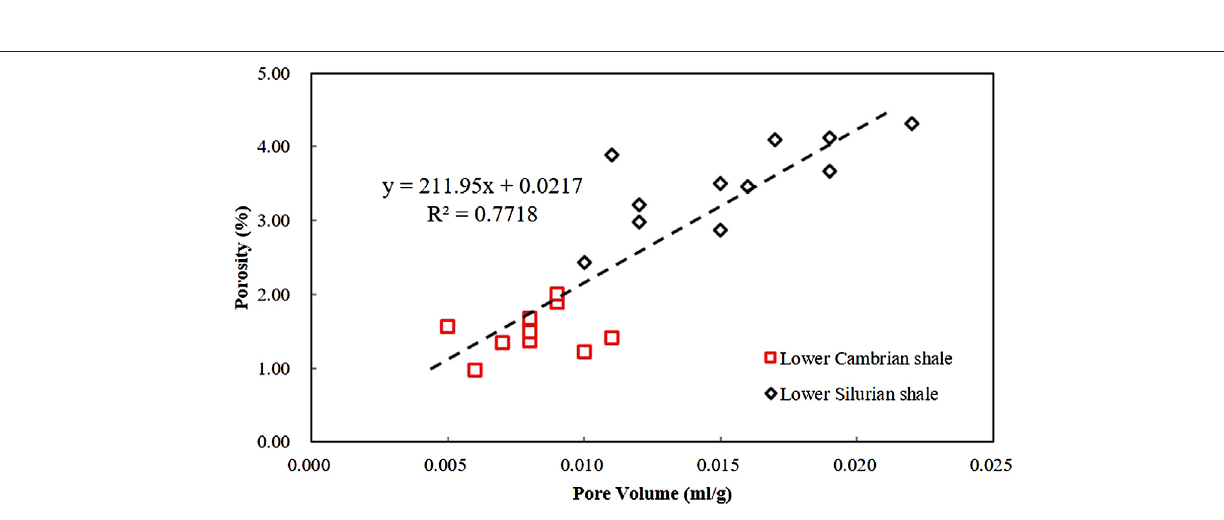
FIGURE 6 | Correlation between helium porosity and N 2 adsorption pore volume